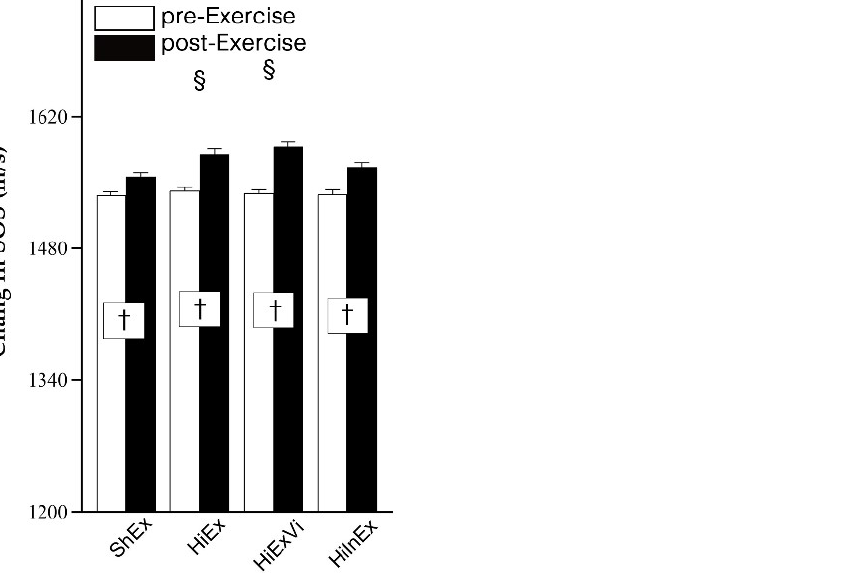
Figure 2. The change in percent of body fat (PBF) and waist–hip ratio (WHR). ShEx—sham exercise; HiEx—high-impact exercise; HiExVi—high-impact exercise with various directions; HiInEx—high- intensity interval exercise. Data are presented as mean ± standard deviation (SD). † indicates that the difference between pre- and post-exercise is significant ( p < 0.05). § denotes that the difference in